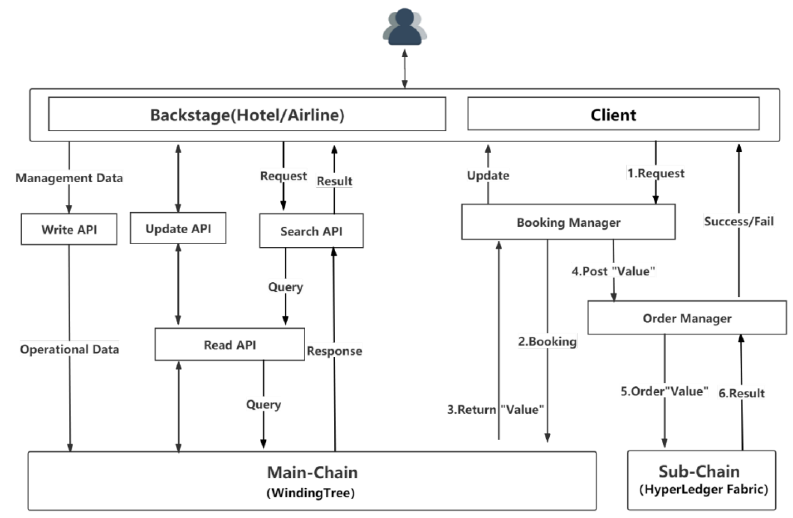
Figure 7. Overview of the multi-chain architecture.